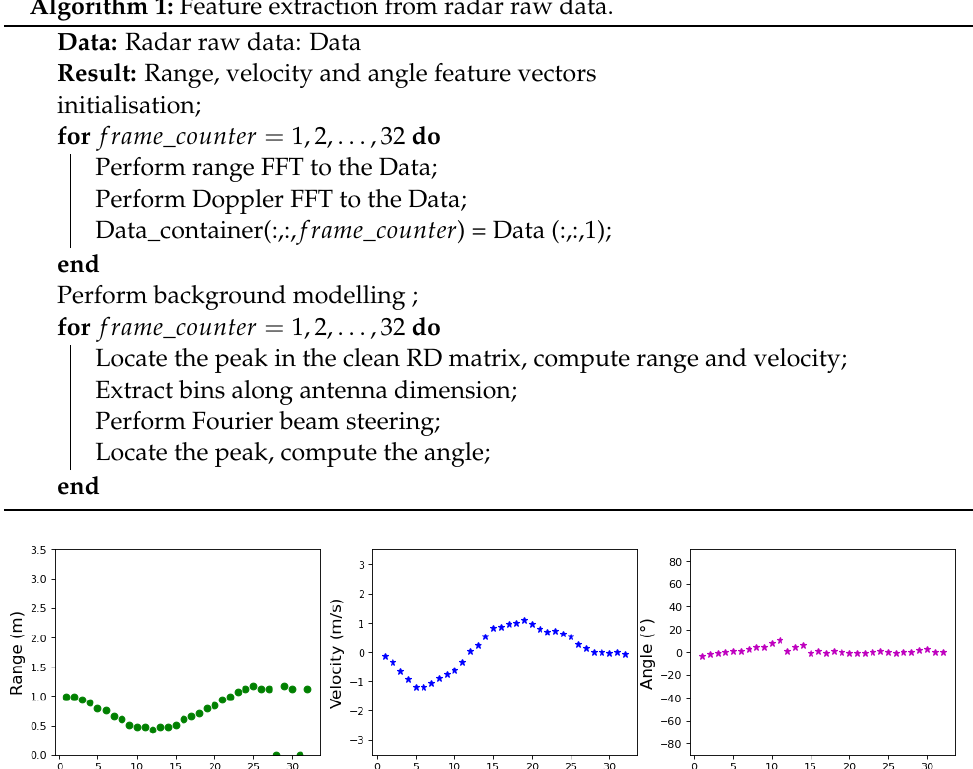
Algorithm 1: Feature extraction from radar raw data.